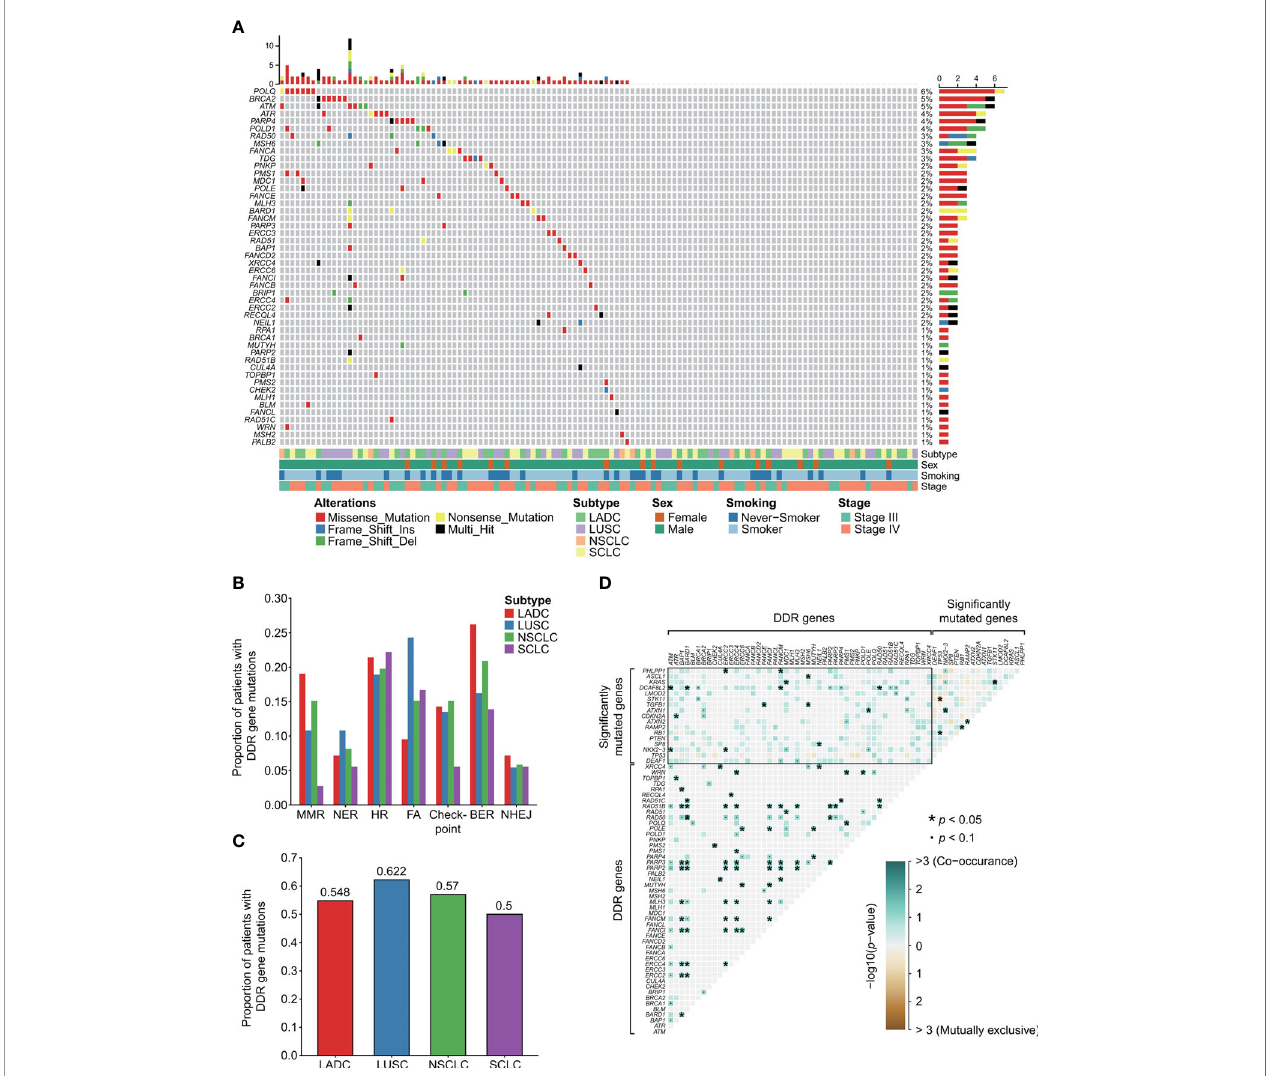
FIGURE 1 | DDR mutational landscape of advanced lung cancers without EGFR or ALK oncogenic driver alterations. (A) Clinical features and DDR mutation spectrum of 122 advanced lung cancer samples without EGFR or ALK mutations/translocations. A total of 67 patients were identi fi ed with deleterious alterations of DDR genes. (B) The number and proportion of mutation samples that occurred in the seven types of DDR related pathways. Chi-square or Fisher ’ s exact tests were used to compare the mutation frequency between distinct subtypes of lung cancers. (C) The proportion of samples with mutations in all DDR genes. (D) Somatic interactions detection. There were widespread comutations between DDR genes and signi fi cantly mutated genes. No mutually exclusive sets between DDR genes and signi fi cantly mutated genes were found. Unlike signi fi cantly mutated genes showing both comutations and mutual exclusions, between DDR genes extensive comutations were extremely frequent. DDR gene coalterations occur both in the same and different DDR pathways. We used the R package “ maftools ” for the detection of co-occurring or mutually exclusive sets of genes. “ * ” means p < 0.05. “(cid:129)” means p < 0.1. The “ checkpoint ” referred to “ cell cycle checkpoint ”